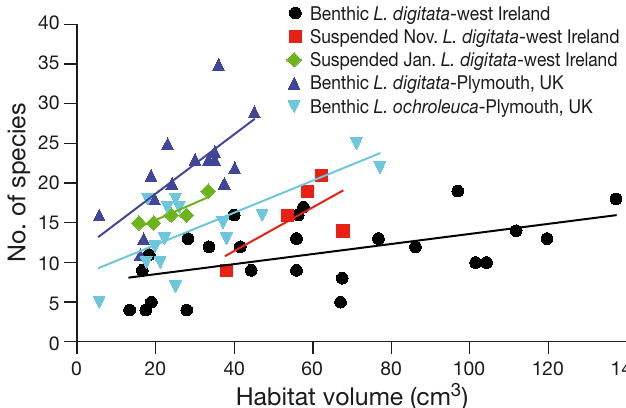
sampled (R = 0.383, p < 0.01). There was also signifi-